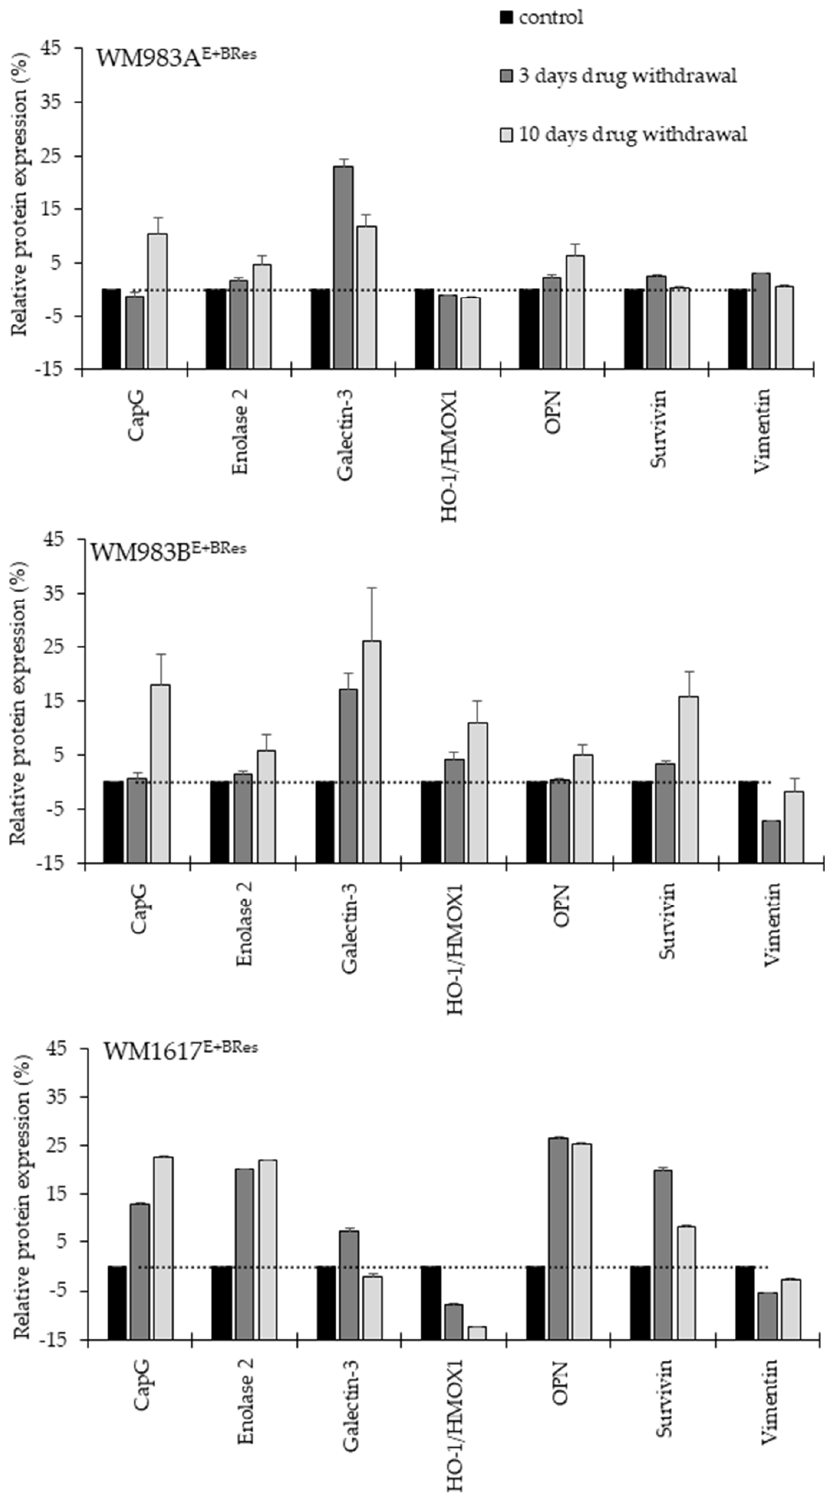
Figure 7. Protein expression changes of the BRAFi/MEKi-resistant melanoma cell lines after 3 and 10 days of drug withdrawal. Control cells were grown in the presence of the 200 nM inhibitor mixture (black columns). Drug withdrawal for 3 days (cells grown in the presence of DMSO: dark grey columns); drug withdrawal for 10 days drug withdrawal (cells grown in the presence DMSO: light grey columns). The data are displayed as the mean ± SD of two independent Protein Profiler Array experiments for each protein.